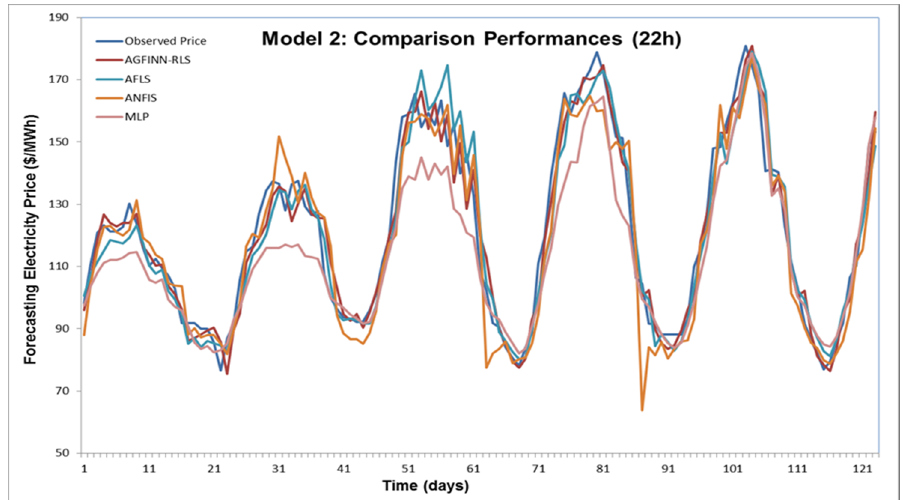
Energies 2019 , 12 , x FOR PEER REVIEW Figure 9. Prediction for electricity price at 22:00—case study 2. Figure 9. Prediction for electricity price at 22:00—case study 2.